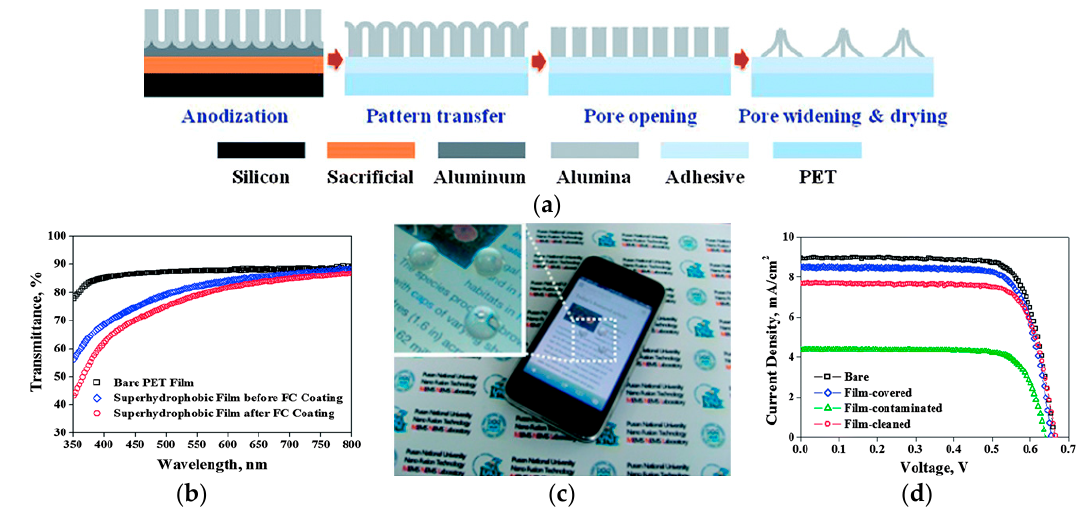
Figure 4. Fabrication of the proposed flexible, transparent, and self-cleanable superhydrophobic film: ( a ) Fabrication procedures; ( b ) optical transmittance of the fabricated superhydrophobic film in the wavelength range of 350–800 nm; ( c ) the flexible film attached to the screen of a mobile phone. ( d ) J – V curves obtained from DSSC under the different film conditions for solar cell application. Reproduced from [66] with permission; Copyright Royal Society of Chemistry 2014.